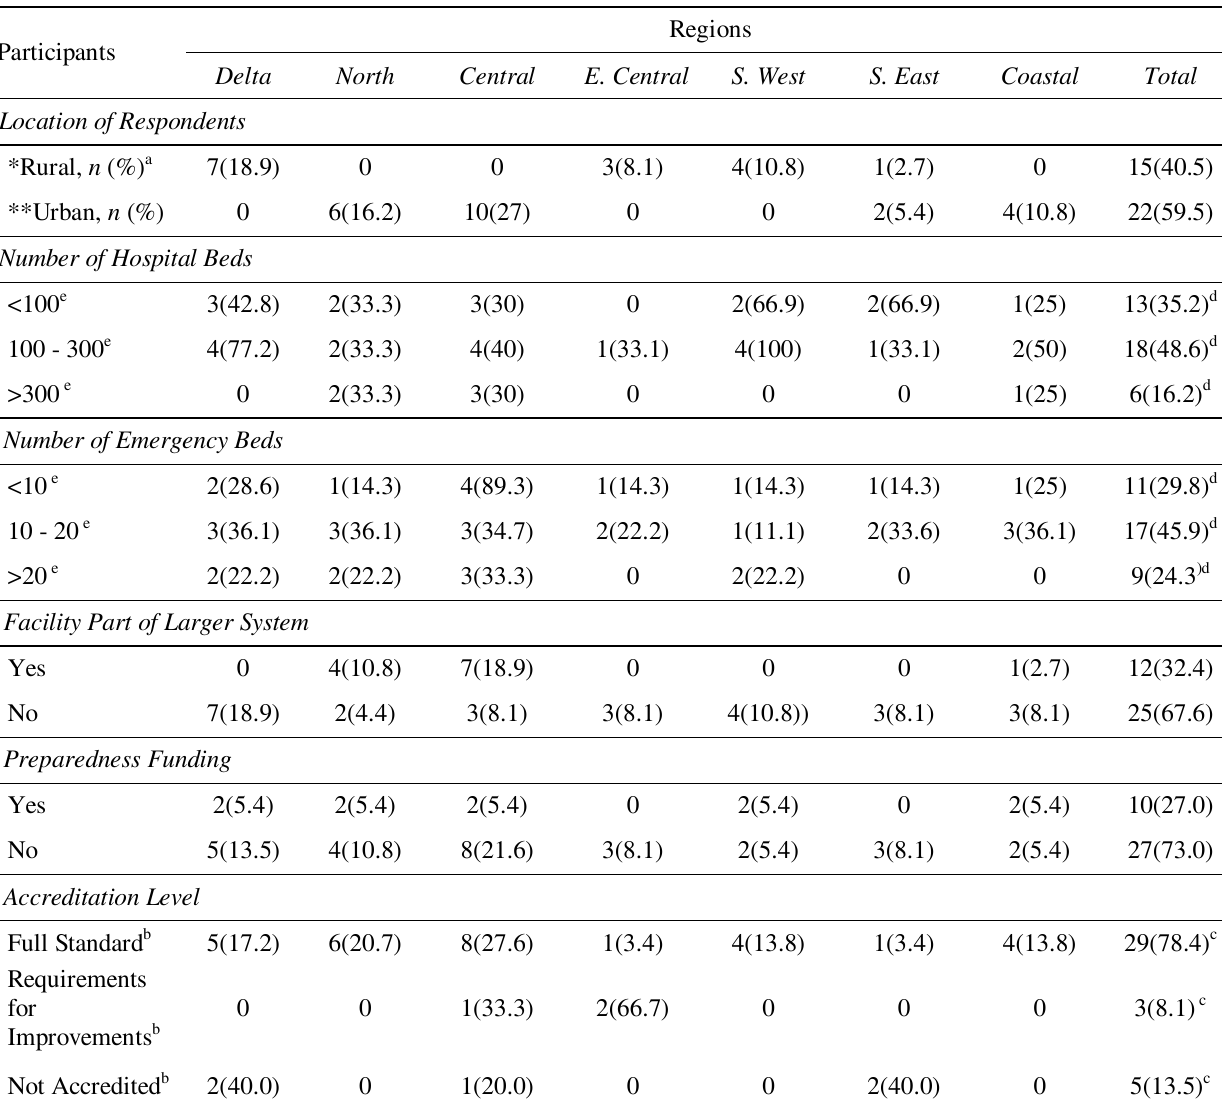
Table 1: Hospitals Participating in the Research on the Preparedness of Hospitals for Managing Victims of an Attack Involving Chemical or Biological Weapons of Mass